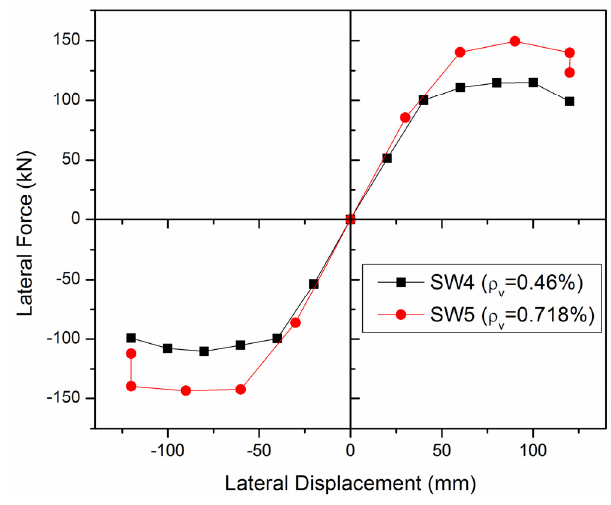
Figure 14. Load-displacement envelopes for different vertical reinforcement ratios for SCMSW Figure 14. Load ‐ displacement envelopes for different vertical reinforcement ratios for SCMSW specimens.